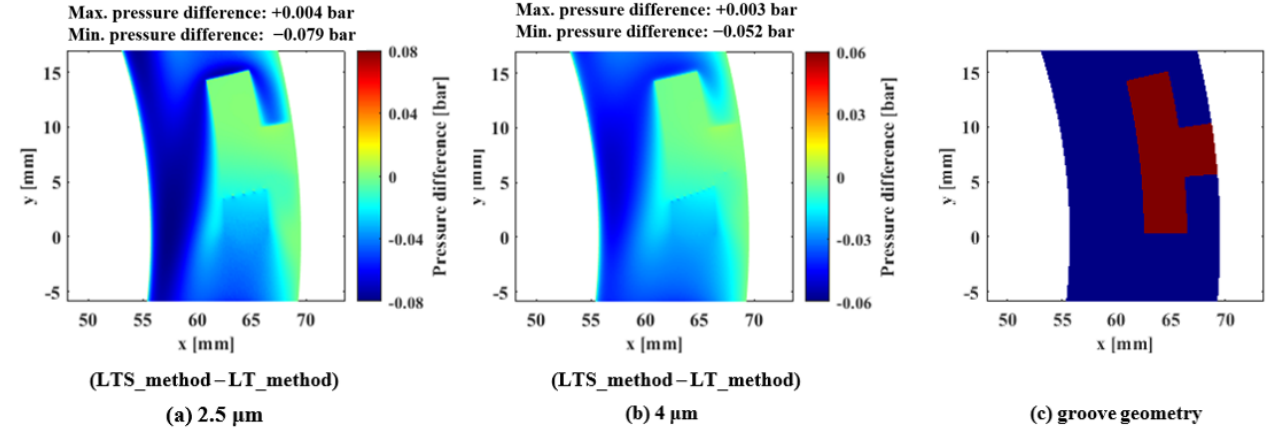
Figure 14. Pressure difference between the LTS_method and the LT_method for a fluid film of 2.5 μ m ( a ) and 4 μ m ( b ) corresponding to T-groove geometry ( c ). Outer pressure = 6 bar.